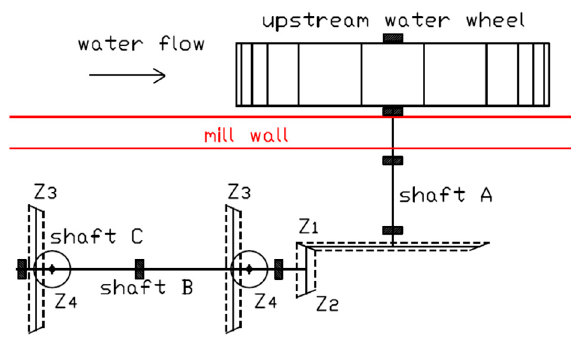
Figure 10. Plan view scheme of the Forno mill upstream water wheel.